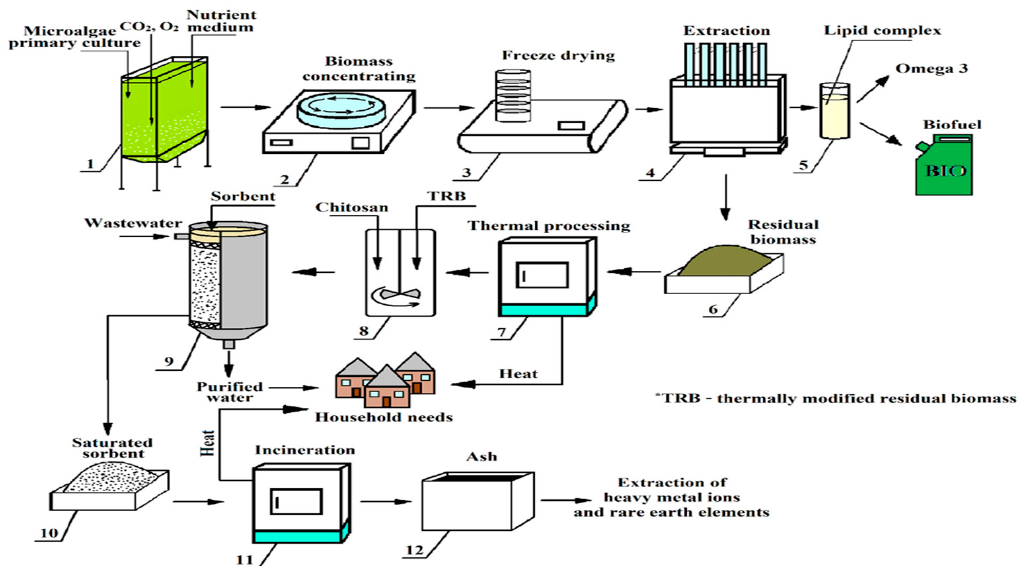
Figure 11. Closed cycle of microalgae biomass utilization with obtained products: 1— photobioreactor; 2—centrifuge; 3—extractor; 4—lipid tank; 5—lipid tank; 6—residual biomass tank; 7—oven for thermal processing of residual biomass; 8—granulator for sorbent obtaining; 9—adsorber for water purification; 10—spent sorbent; 11—oven for incineration of spent waste; 12—ash